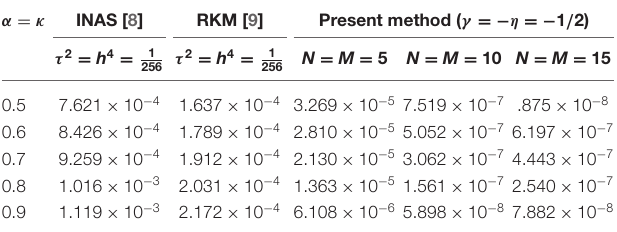
TABLE 2 | Case II: The L ∞ -error for example 5.1.